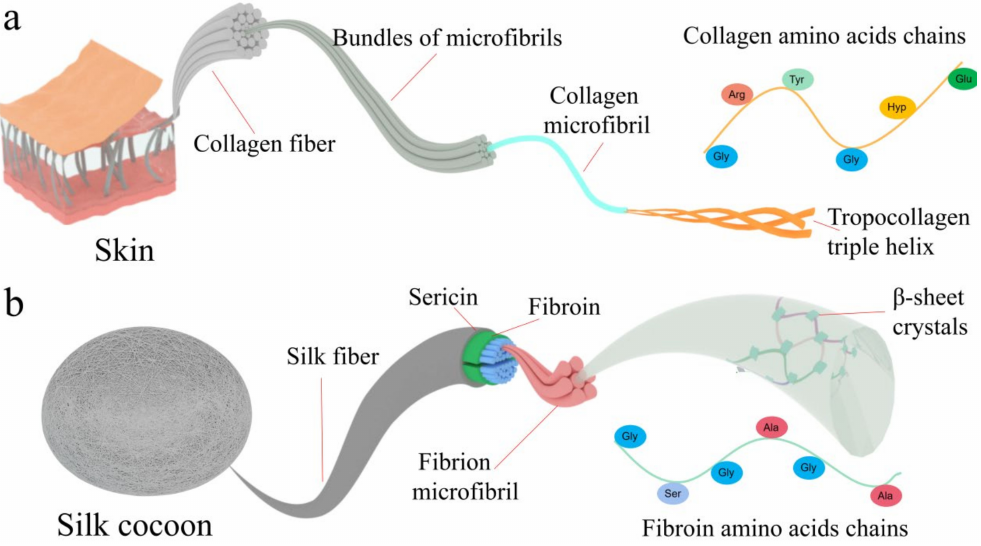
Figure 2. Hierarchical structures of collagen and silk fibroin. ( a ) Schematic diagram of skin, collagen fiber, triple helix, and molecular structure. ( b ) Schematic diagram of cocoon, silk fiber, sheet, fibroin, and molecular